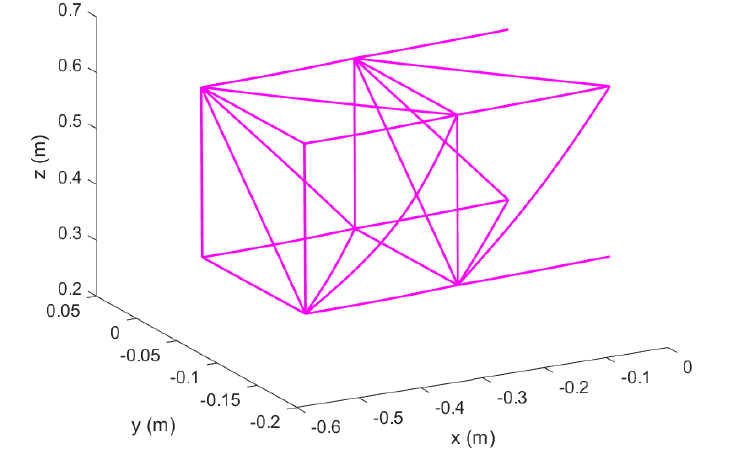
Figure 26. Mode 1 of Timoshenko beams in Topology 1 with hinged ends; original configuration.